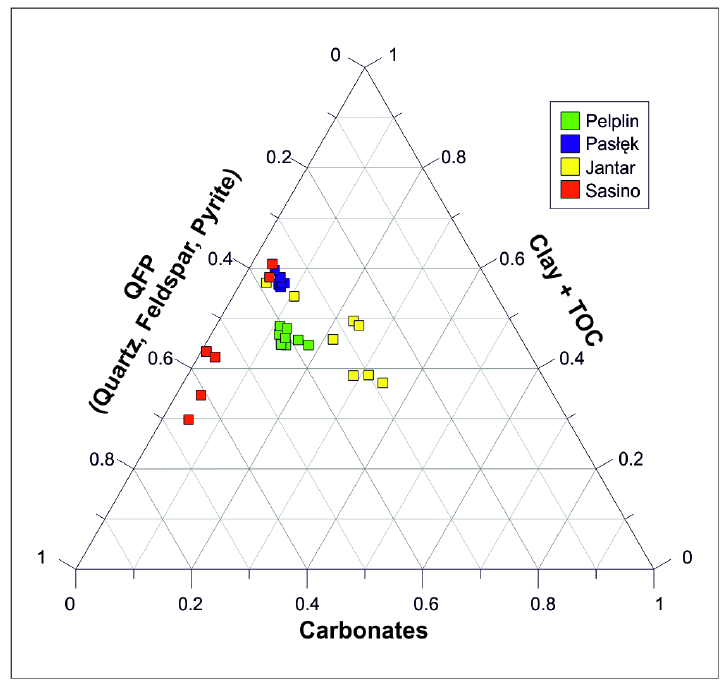
Figure 3. Mineral composition of the analysed siltstone-claystone formations. Table 1. Mineral composition and organic matter (TOC) content in the studied siltstone-claystone formations.